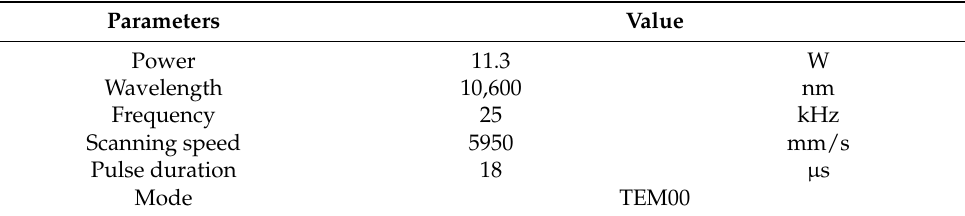
Table 2. Laser parameters for realizing dimples, obtained from preliminary tests.